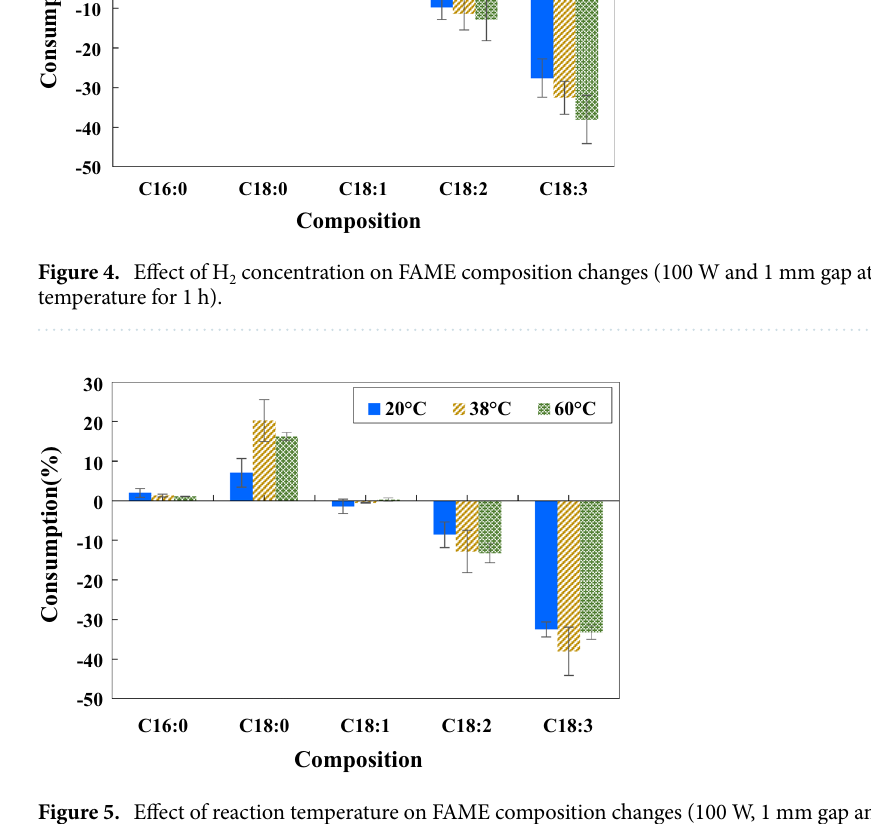
Figure 5. Effect of reaction temperature on FAME composition changes (100 W, 1 mm gap and 80%H 2 for 1